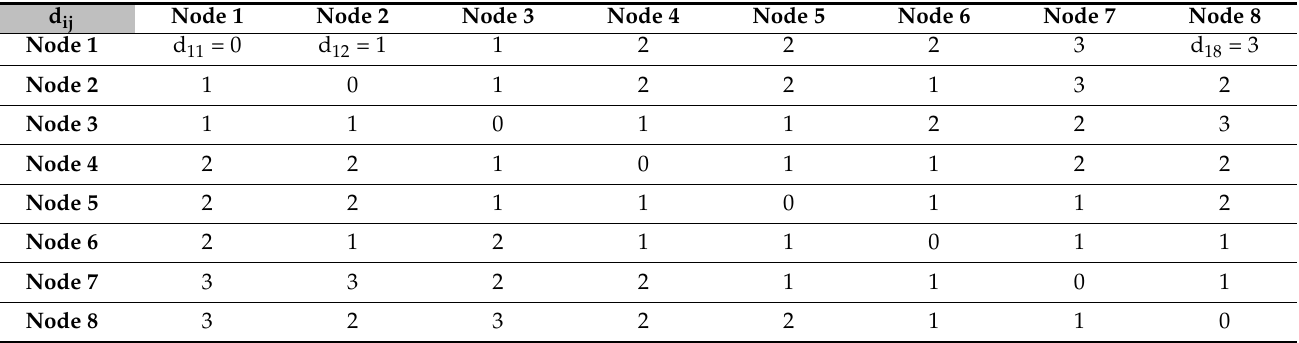
Table 9. Shortest path distances dij, for every pair of